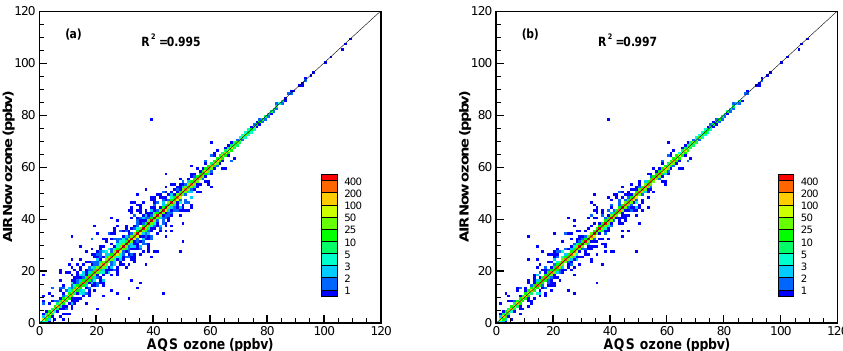
Fig. 3. Comparison between AIRNow and AQS data on 31 May 2010 before (a) and after (b) removing the 74 questionable sites using density plots, in which color represents the count of observation pairs at each pixel. The data between 00:00EDT and 23:00EDT are included